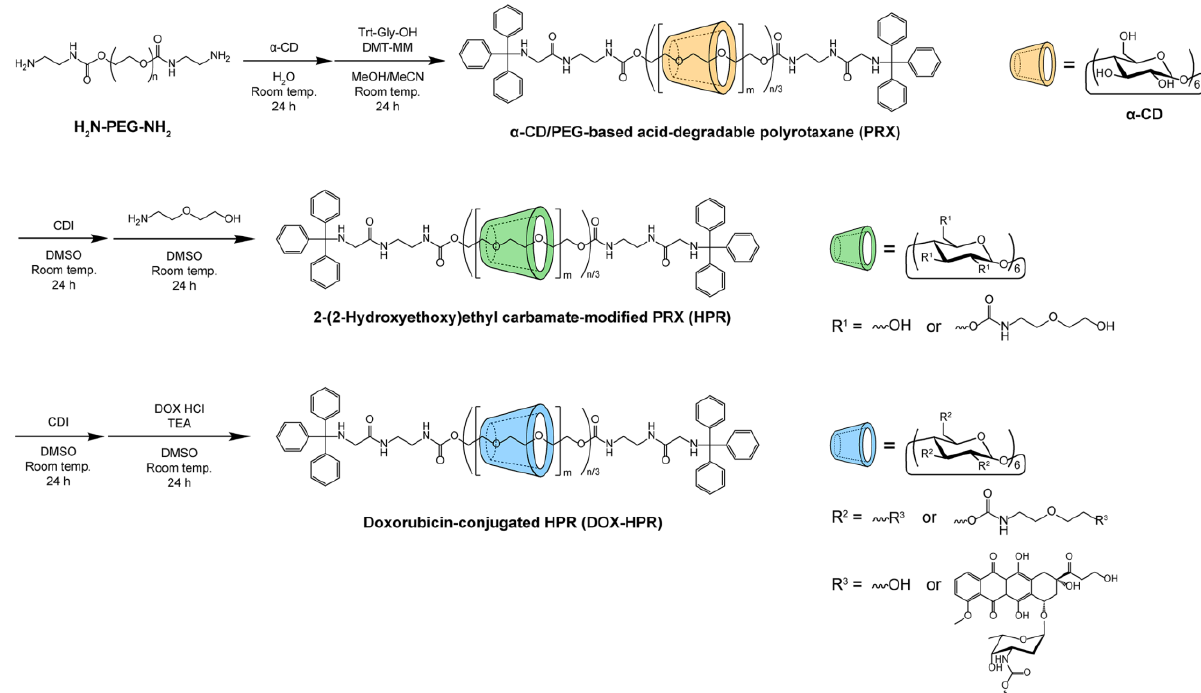
Figure 2. Synthetic scheme for doxorubicin (DOX)-conjugated acid-degradable PRXs. DOX was conjugated with the threaded α -CDs in HPR as shown in Figure 2; the amino groups of daunosamine sugar moieties in DOX were bonded to the hydroxy groups